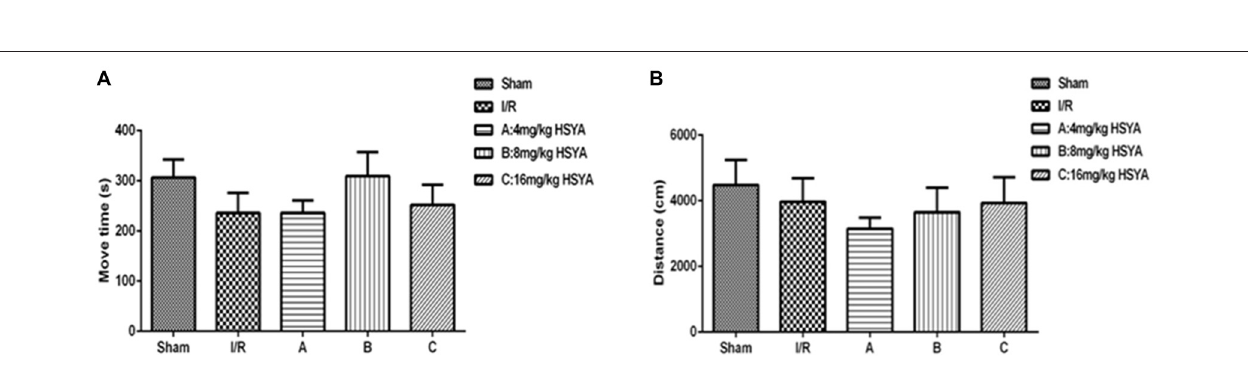
FIGURE 2 | Locomotor activity of HSYA on open field test. (A) Move time, (B) distance. The values are shown as means ±